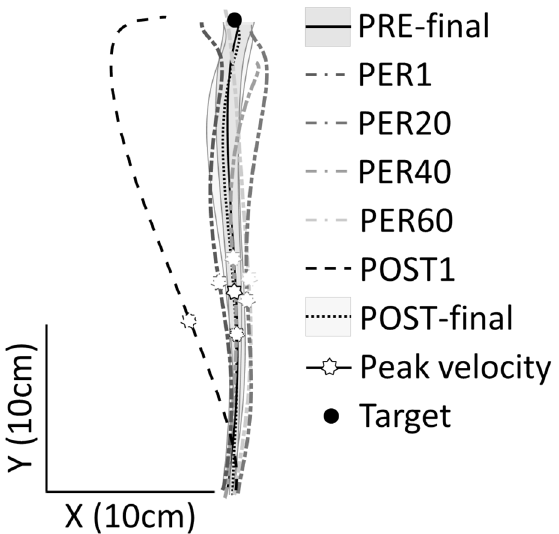
Figure 3. Top-view of manual reaching trajectories for a representative participant. Hand paths correspond to the mean trajectory of the ten last trials in PRE-rotation (PRE-final, black line), the first (PER1), the twentieth (PER20), the fortieth (PER40) and the sixtieth (PER60) trial in PER-rotation (gray dash-dotted lines), the first trial in POST-rotation (POST1, black dashed line) and the ten last trials in POST-rotation (POST-final, black dotted line). Standard deviations from the mean trajectories in PRE-final and POST-final are represented in gray areas. An after-effect was visible in the first trial following removal of the Coriolis force (POST1), which differed markedly from all other